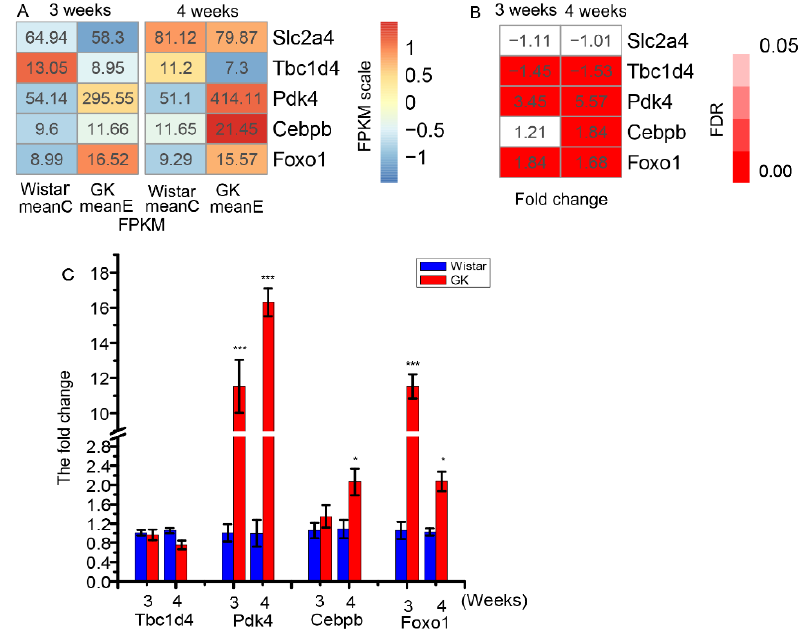
Figure 3. The differentially expressed genes related to glucose uptake and oxidation. ( A ) The mean fragments per kilobase of exon per million fragments mapped (FPKM) of Pdk4 , Slc2a4 , Tbc1d4 , Cebpb and Foxo1 in skeletal muscle of GK and Wistar rats. ( B ) The fold change (meanE/meanC) and corresponding false discovery rate (FDR) values of Pdk4 , Slc2a4 , Tbc1d4 , Cebpb and Foxo1 in GK rats in comparison with those of Wistar rats. ( C ) The fold change (2 −ΔΔCt ) of GK genes Pdk4 , Tbc1d4 , Cebpb and Foxo1 expression compared with Wistar rats by RT-qPCR (data are shown as mean ± SEM. n = 6, * P < 0.05, *** P < 0.001). MeanC represents the mean FPKM of Wistar rats, while meanE represents the mean FPKM of GK rats.